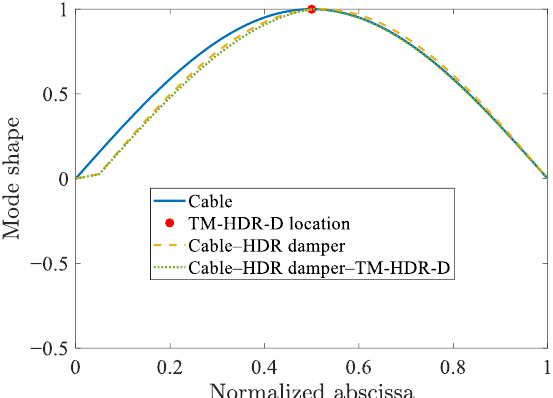
Figure 6. Modal shapes of cables with different dampers.